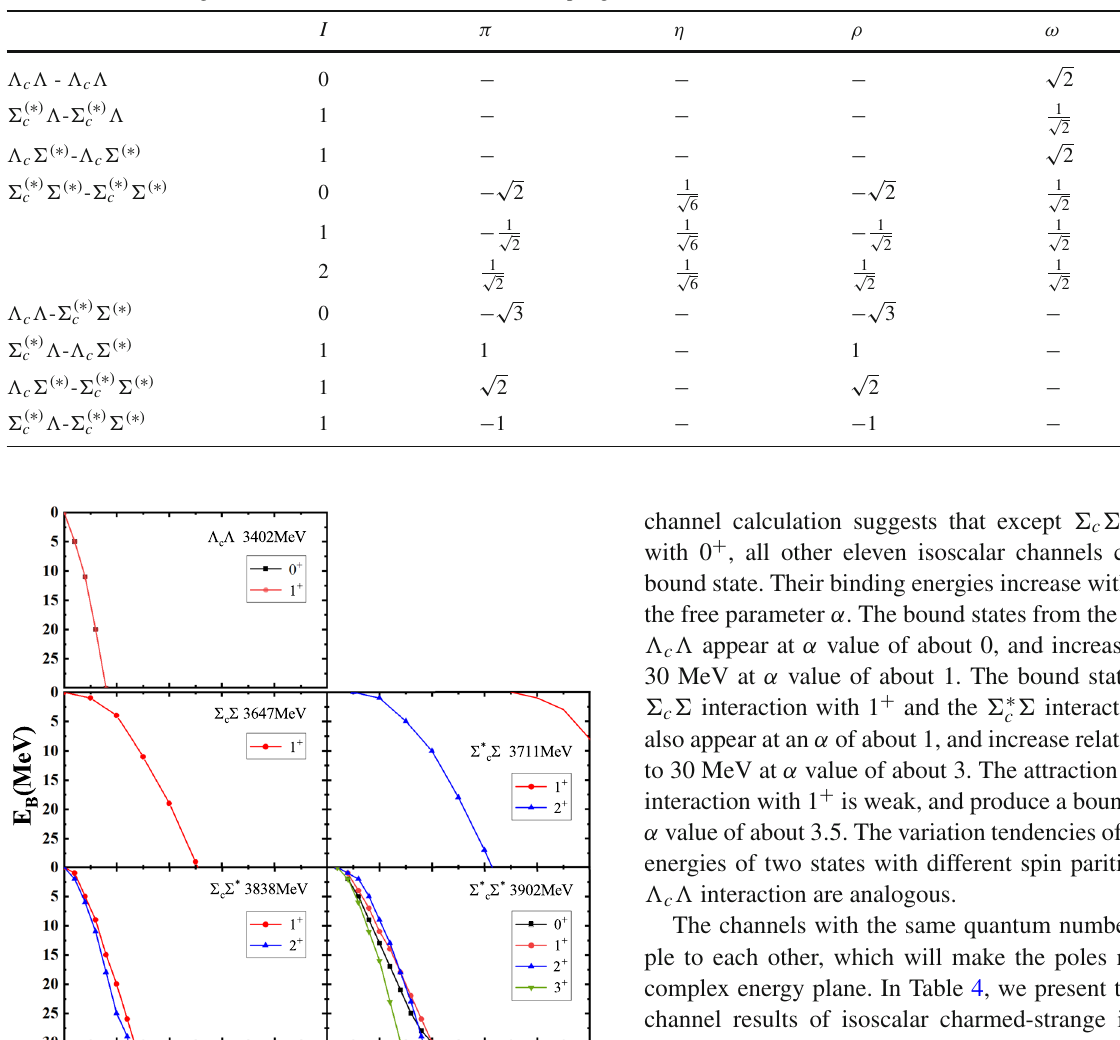
Table 3 The flavor factors I e for charmed-strange interactions. The values for charmed-antistrange interactions can be obtained by Eq. (14) from these of charmed-strange interactions. The I σ should be 0 for coupling between different channels